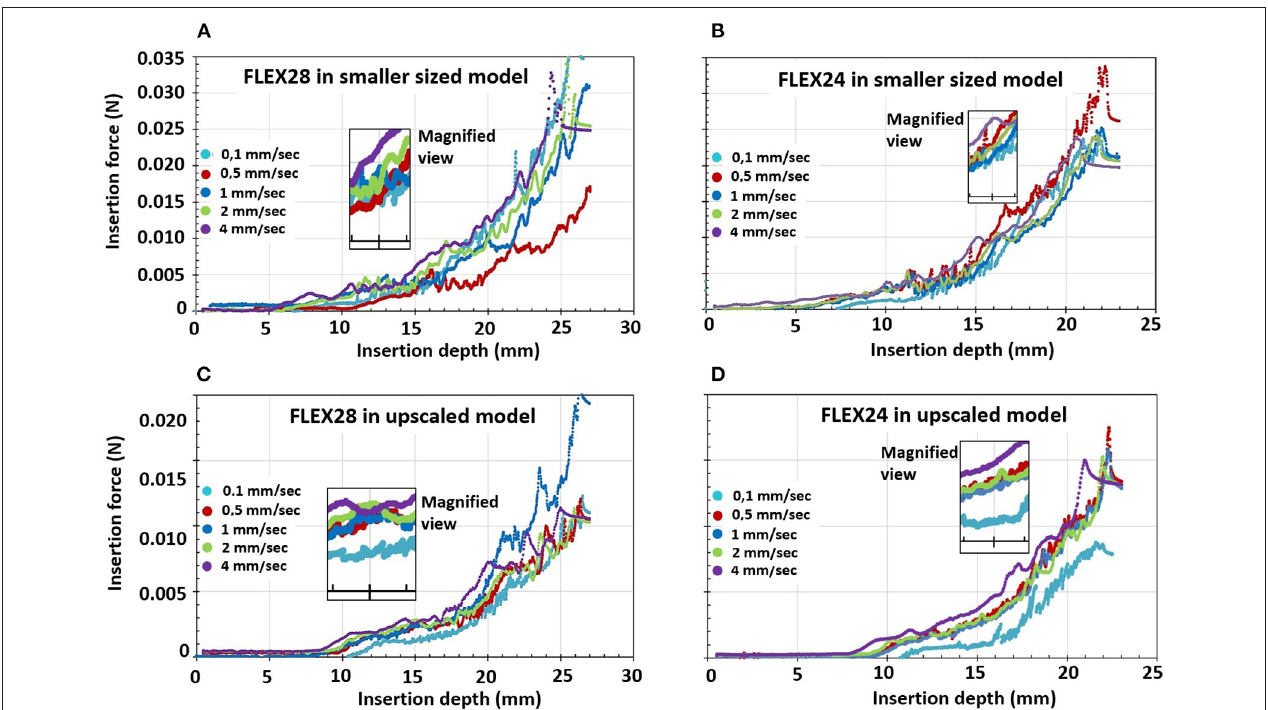
FIGURE 6 | Electrode insertion force measurement of FLEX28 and FLEX24 electrodes in two different sized cochlear model applying five different insertion speeds of 0.1, 0.5, 1, 2, and 4 mm/s. (A) FLEX28 and (B) FLEX24 in the average sized cochlea model. (C) FLEX28 and (D) FLEX24 in the upscaled model. The inner magnified view shows the insertion force curves for various insertion speeds at 15mm of insertion depth. The purple curve corresponds to the highest insertion speed of 4 mm/s showing higher insertion forces and the turquoise curve corresponds to the lowest insertion speed of 0.1 mm/s showing lower insertion forces.